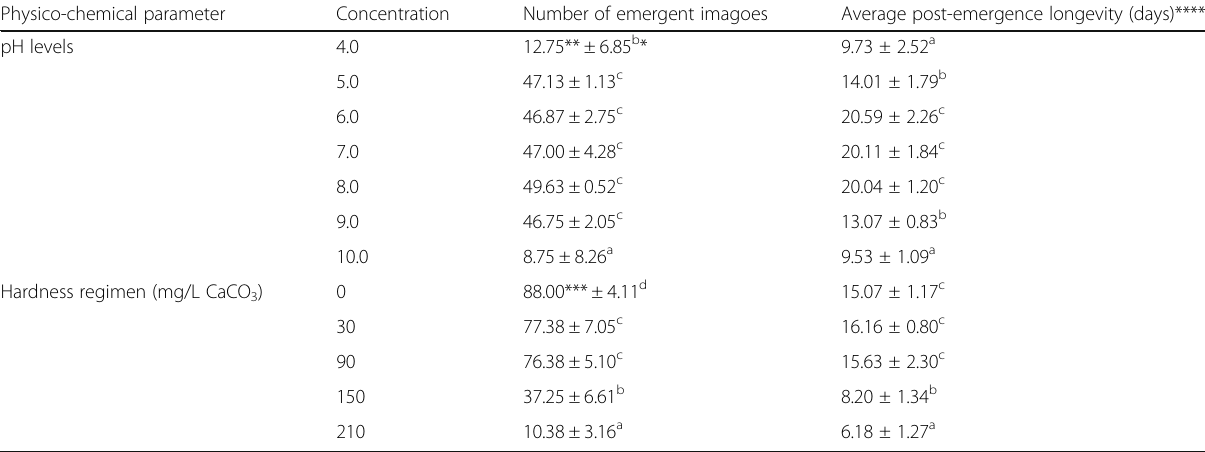
Table 4 Effects of water pH and hardness levels on emergence rates and longevity of adult life stage of Culex quinquefasciatus Physico-chemical